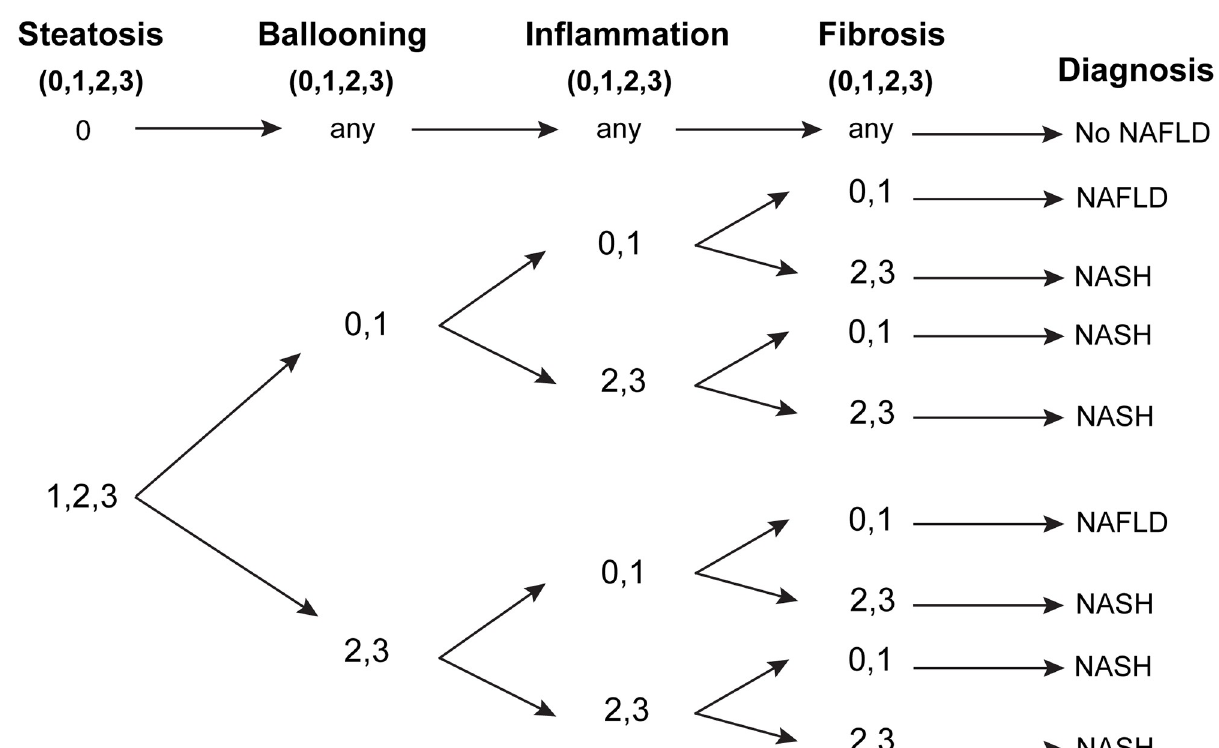
Fig 2. Diagnostic algorithm for differentiation of NAFLD and NASH at the liver parenchyma [31].